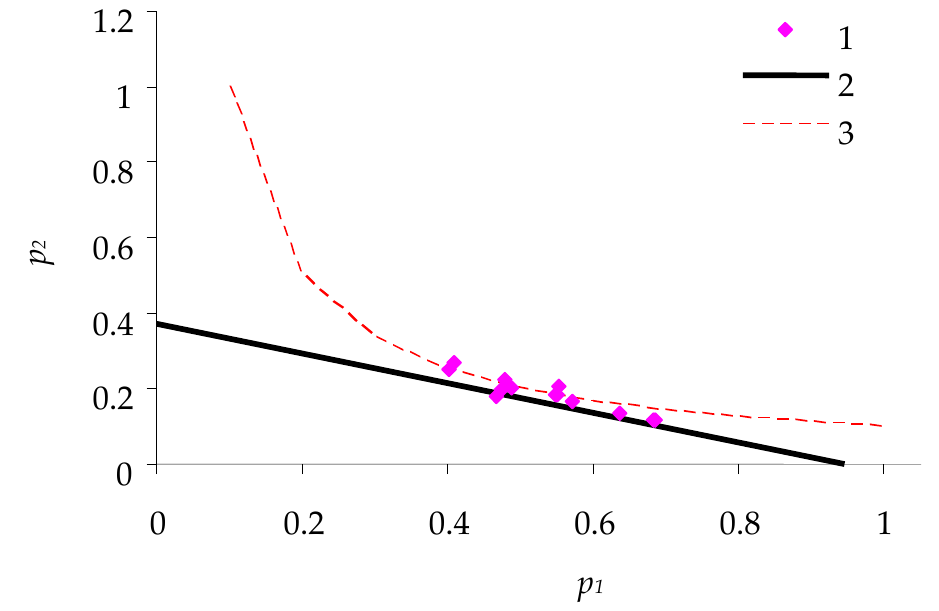
Figure 5. The energy balance of spongy moth females on larch: (1) data on caterpillars; (2) line of budgetary constraints; (3) hyperbola of optimal consumption.